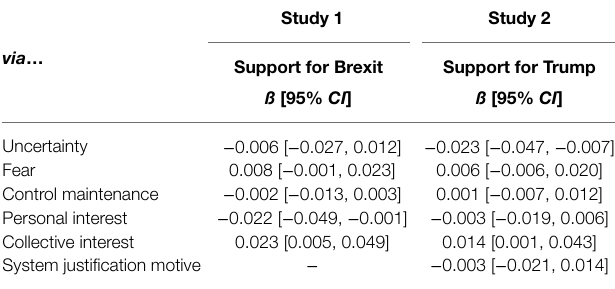
TABLE 4 | The indirect effect of voting preference on Post-Referendum Support for Brexit (Study 1), Post-Election Support for a Trump administration (Study